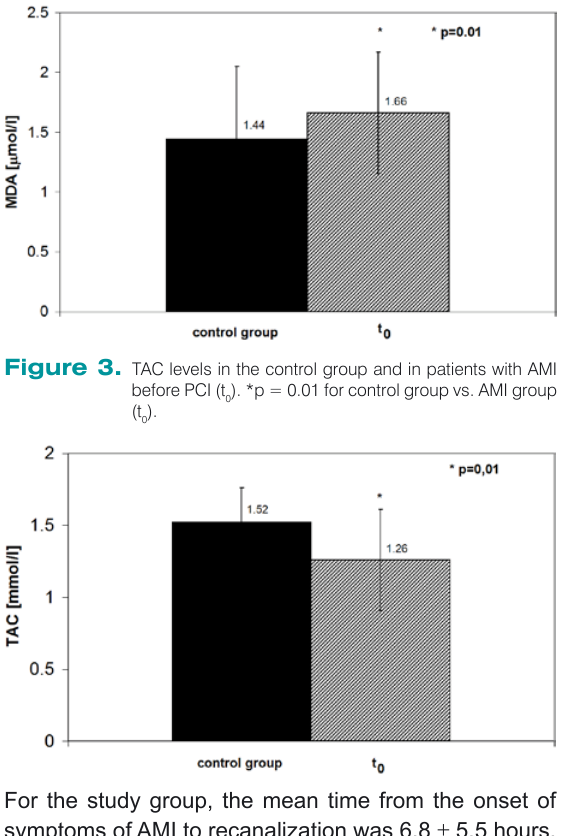
) and after 0 , 1 h after 60